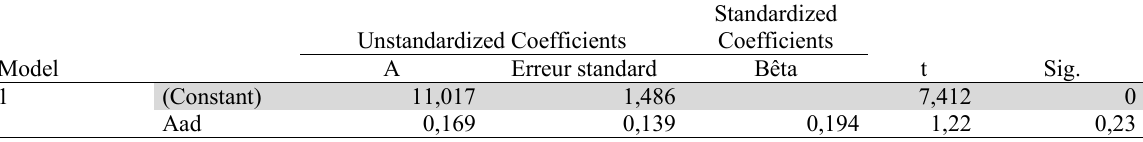
Unstandardized Coefficients